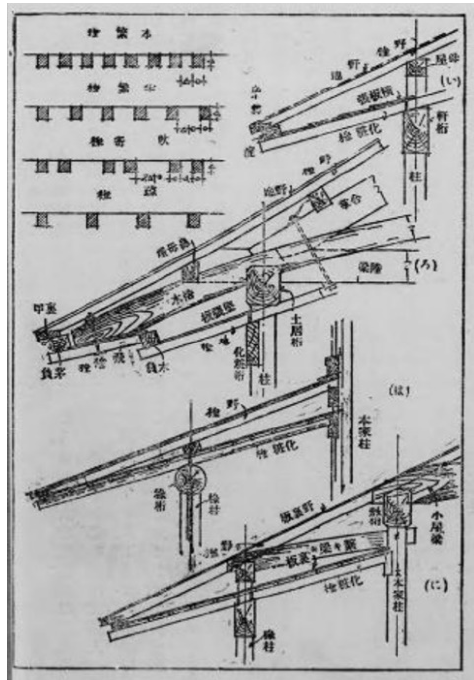
Figure 19. Techniques of Protruding Eaves Introduced in Improved Japanese House Structure [20].